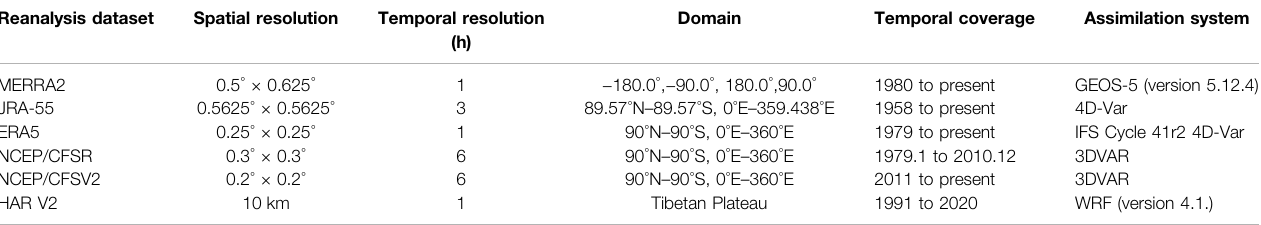
TABLE 2 | Detailed information of the fi ve reanalysis radiation